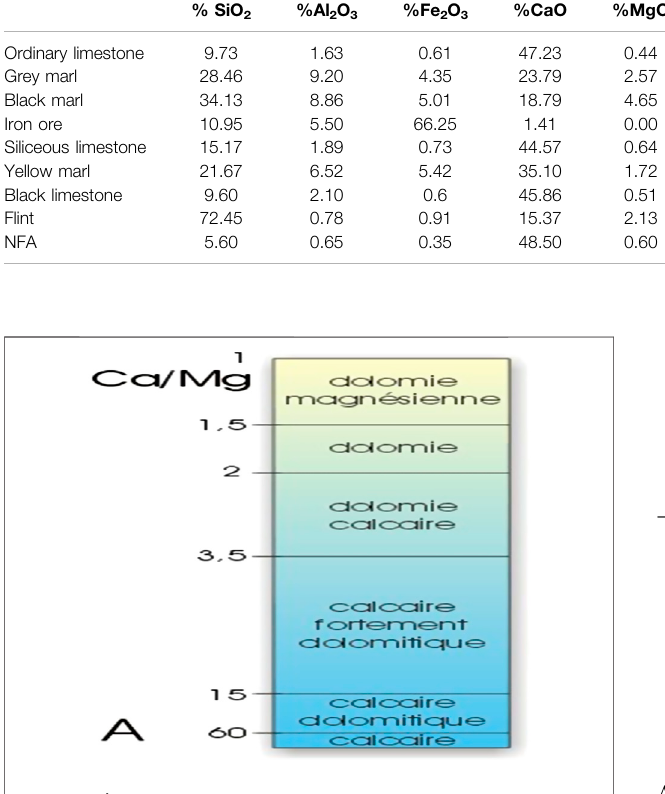
FIGURE 6 | Classi fi cation of carbonate rocks according to the Ca/Mg ratio (Boulvain, 2014).